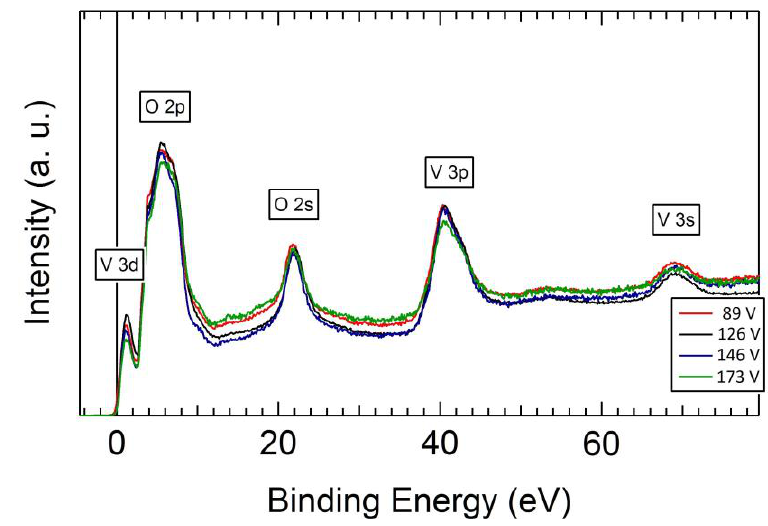
Figure 3. XPS spectra of the as-deposited VO 2 thin films with substrate biasing.